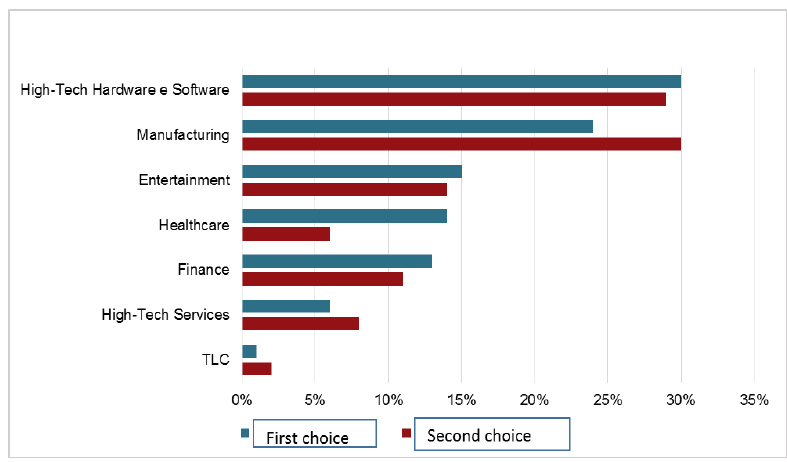
Figure 7. Students and Graduates: Desire for First Job (Which Sector Would Students/Graduates Choose to Work